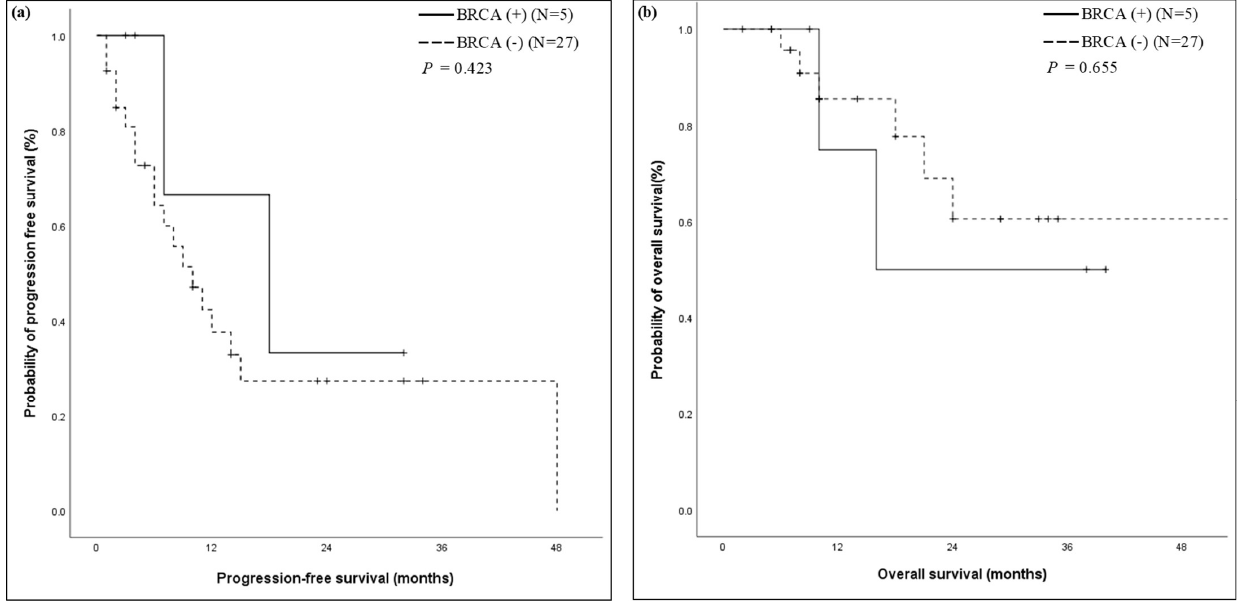
Figure 2. Kaplan–Meier curve in patients with first-line FOLFIRINOX stratified by the presence of a germline BRCA gene mutation. ( a ) The PFS was 18 months (95% confidence interval 0.4–35.6)